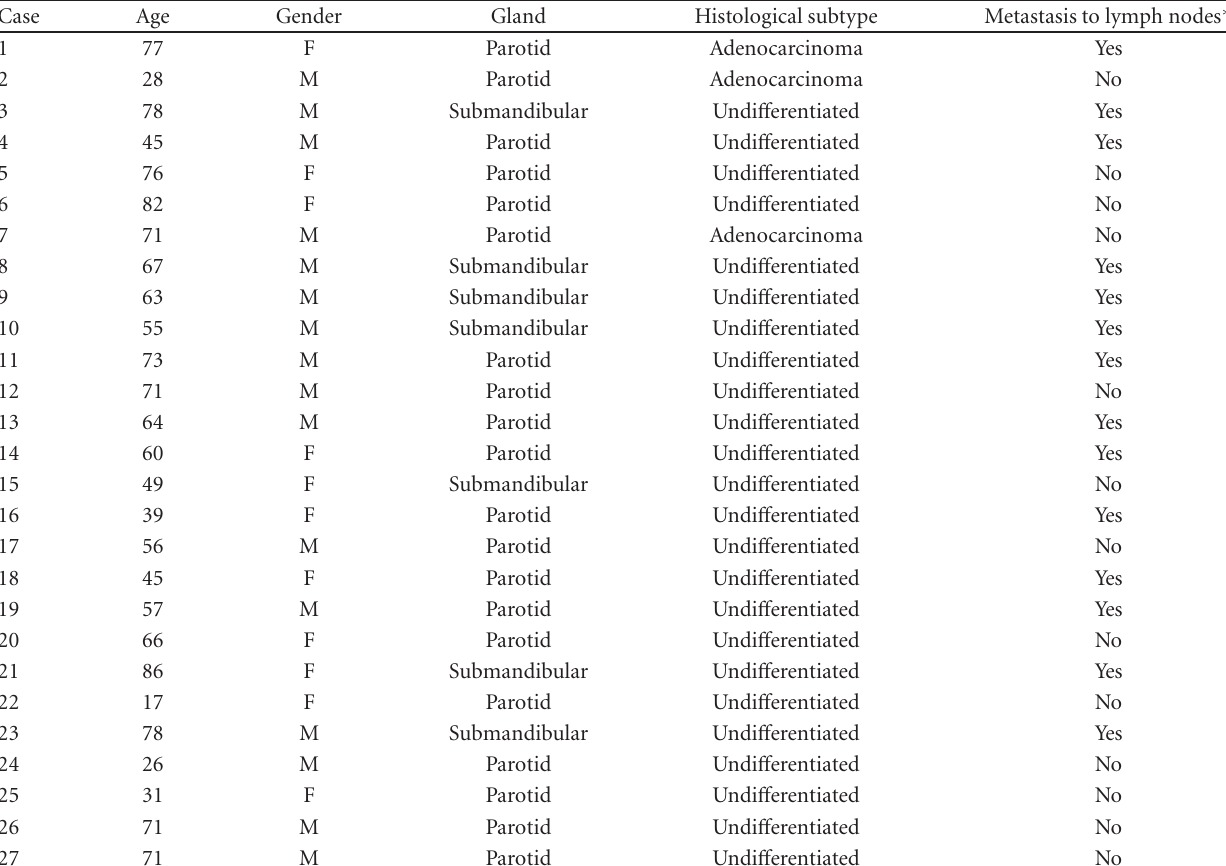
Table 2: Clinical data of cases from carcinomas ex pleomorphic adenomas.